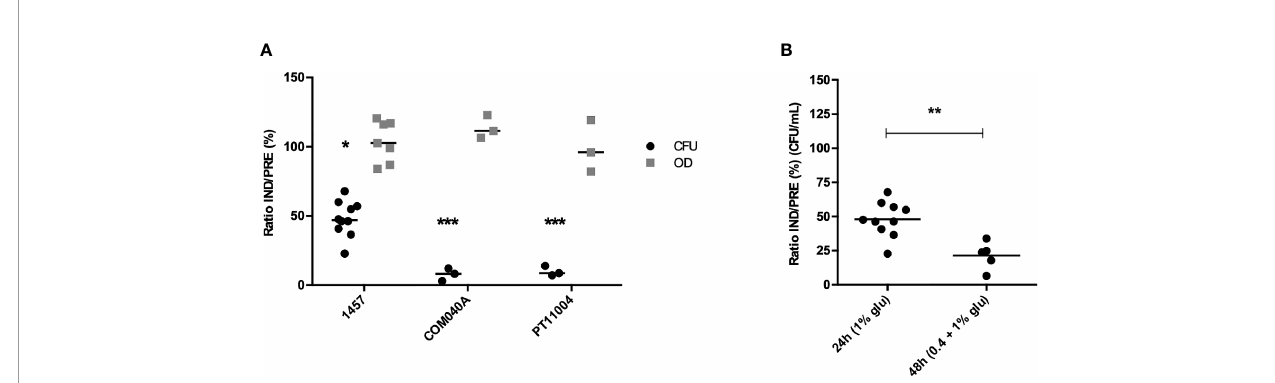
FIGURE 3 | Culturability (CFU/mL) and total amount of cells (OD 640nm ) of (A) S. epidermidis 1457, COM040A and PT11004 24 h-old planktonic suspensions grown under induced (IND) and prevented (PRE) VBNC conditions. Data is represented as the ratio (%) of the culturability (CFU) or OD between cells in the IND or PRE VBNC state; and (B) S. epidermidis 1457 planktonic cells grown under IND and PRE VBNC conditions using two different growth strategies: (i) planktonic cells grown for 24 h in 1% glucose and (ii) planktonic cells grown for 24 h in 0.4% glucose + 24 h in 1% glucose; in both strategies 20 mM of MgCl 2 was added in the prevented condition. Data is represented as the result of the individual assays, where the horizontal lines represent the mean of at least three independent experiments. * p < 0.05, ** p < 0.01, *** p < 0.001 (Unpaired Welch ’ s T-test). Glu,